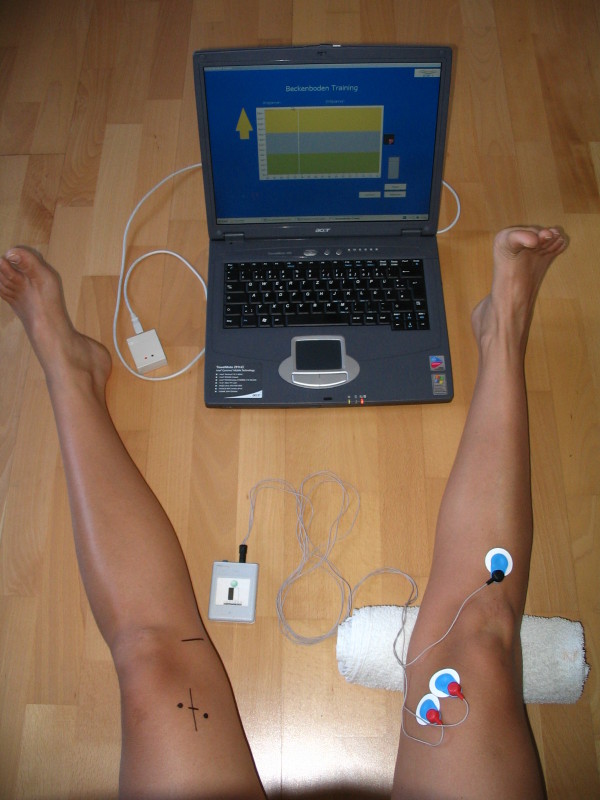
The iEMG measuring.